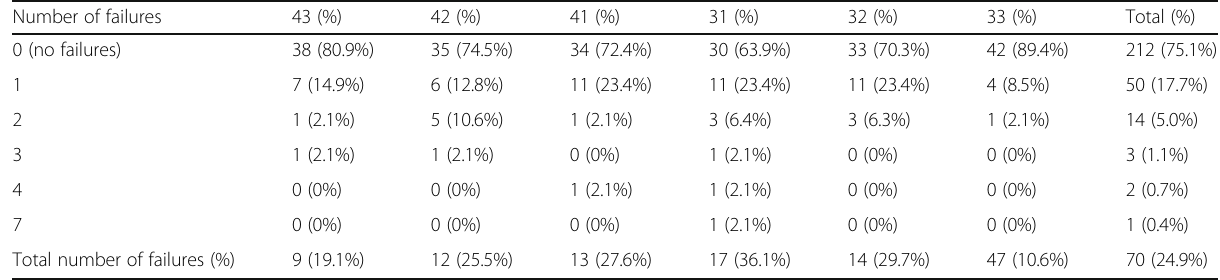
Table 5 Number of failures according to tooth type in the mandible for the . 016 ″ × .022 ″ braided SS retainers (47 patients, 282 total bonded